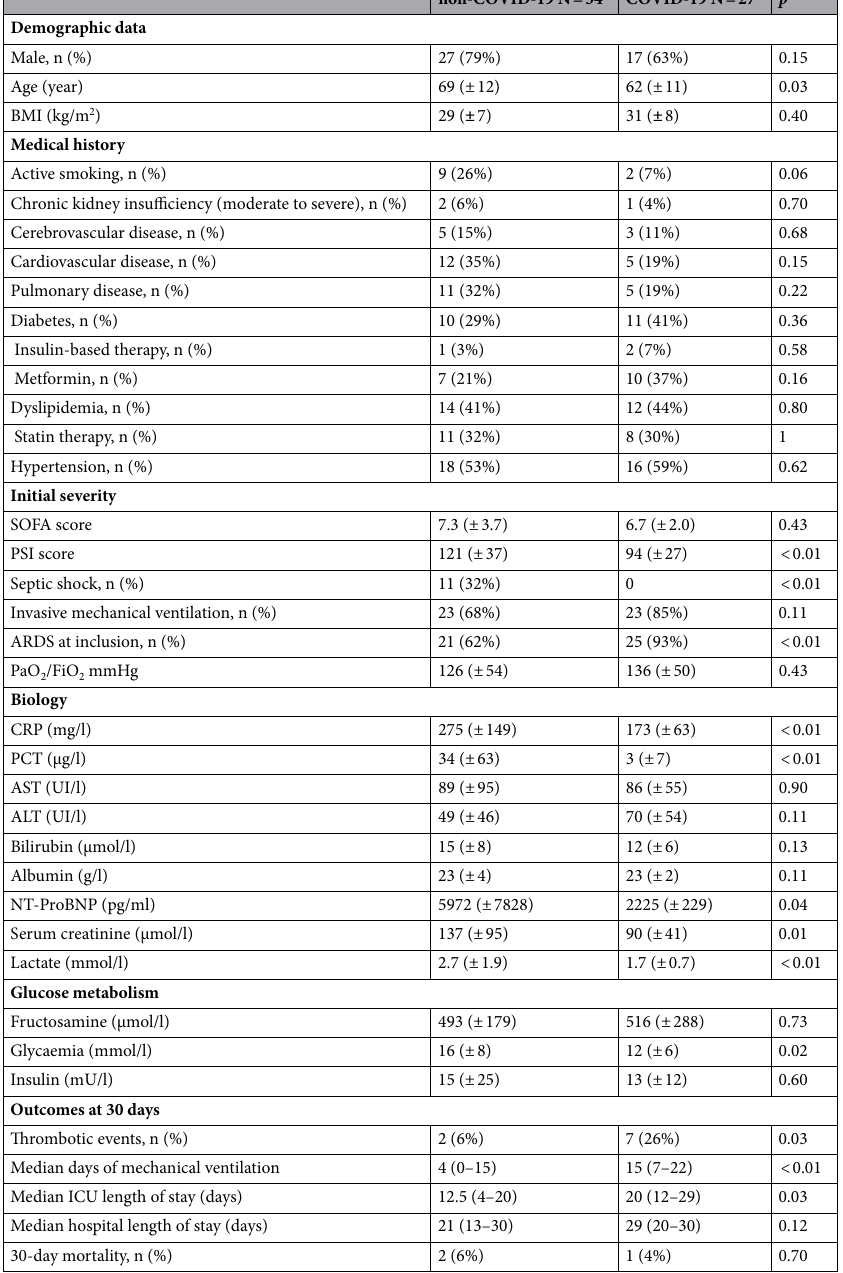
Table 1. Patient characteristics according to COVID-19 status. BMI body mass index, SOFA sequential organ failure assessment, PSI pneumonia severity index, PaO 2 arterial oxygen partial pressure, FiO 2 fraction of inspired oxygen, RRT renal replacement therapy, CRP C-reactive protein, PCT procalcitonin, AST aspartate transaminase, ALT alanine transaminase, BNP brain natriuretic peptide; ICU: intensive care unit. Quantitative data are presented as mean ± SD or Median